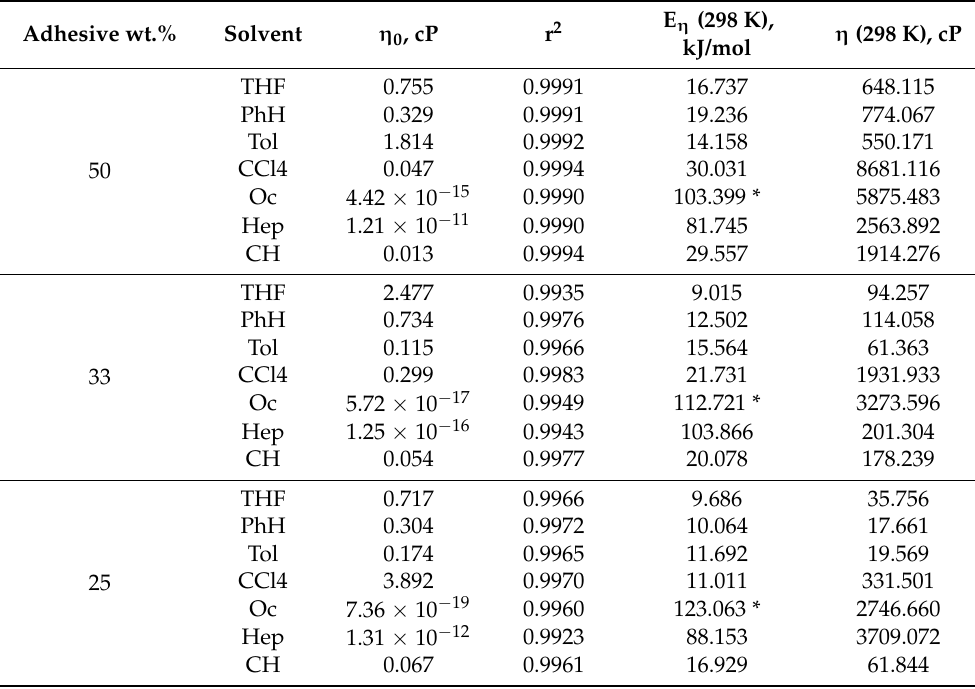
Table 1. Fitting parameters of the adhesive solution viscosity data to Arrhenius Model. Adhesive